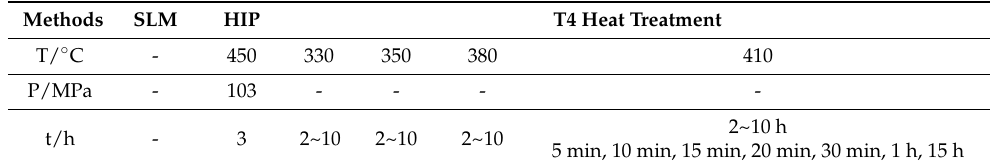
Figure 1. ( a ) Schematic of T4 heat treatment process; ( b ) Geometry of the tensile specimen. Table 3. Experimental conditions of heat